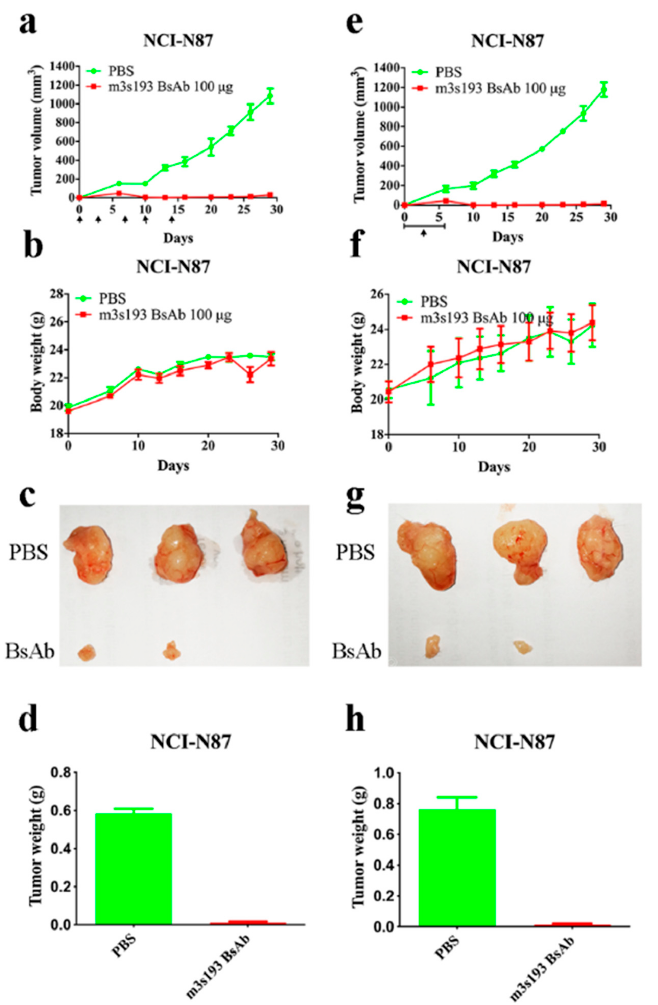
Figure 5. In vivo anti-tumor activity of m3s193 BsAb. Mice were treated i.v. with PBS ( n = 3) and 100 µg dosage of m3s193 BsAb ( n = 5). ( a – d ) Mice were treated on day 0, twice a week, 5 times. ( e – h ) Mice were treated on day 0–6, 7 times. ( a , e ) Tumor growth curve plotted according to tumor volume and time. Black arrows indicate the time of therapy. ( b , f ) Mice body weight variation with time course. ( c , g ) The digital image of stripped tumors at study termination. ( d , h ) Tumor weight in two groups. Data are presented as mean ± SD.